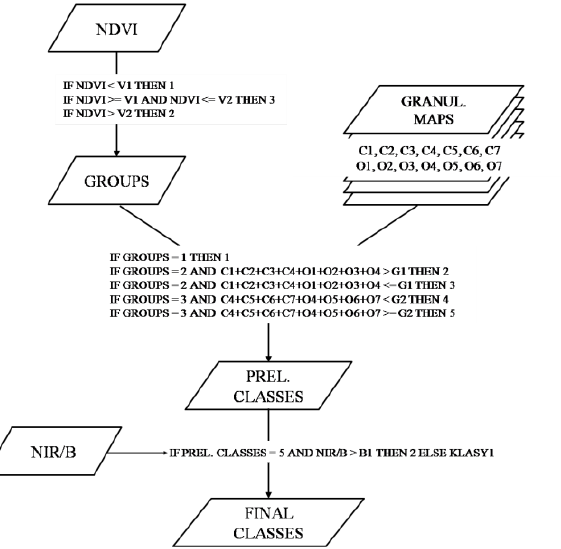
Figure 3. Block diagram of the classification model. Number of classes according to the list presented in section